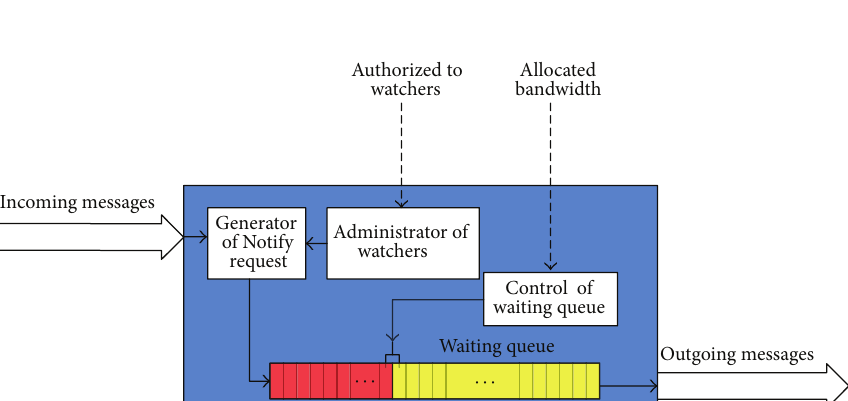
Figure 4: Subscribe status.